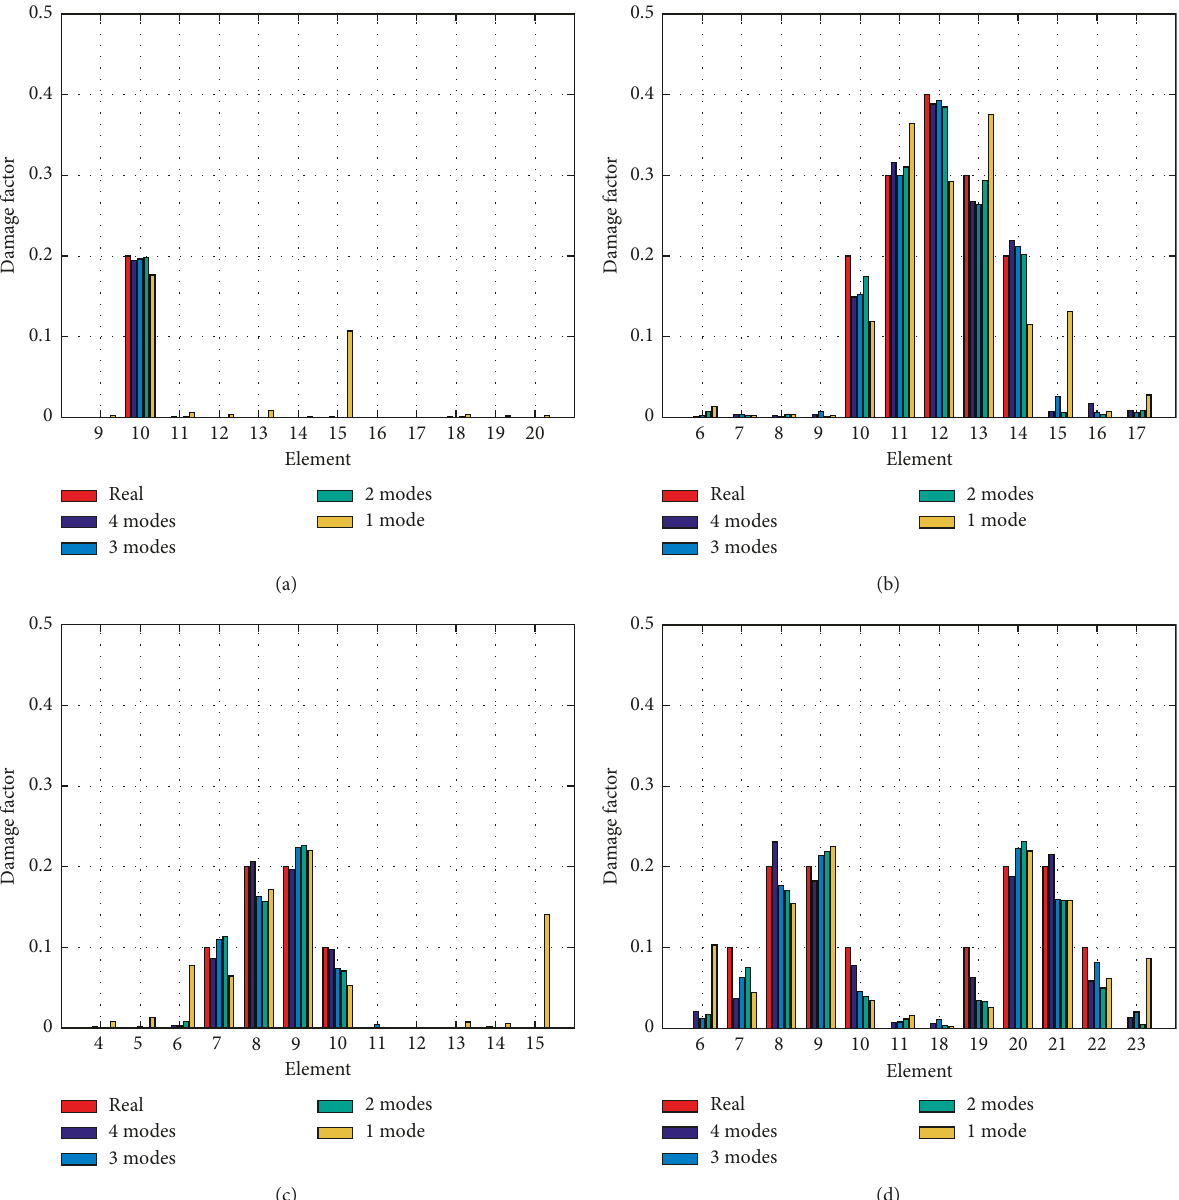
Figure 14: Frame example: damage prediction of the combined criterion for the four damage scenarios (no noise). (a) Scenario 1, (b) scenario 2, (c) scenario 3, and (d) scenario